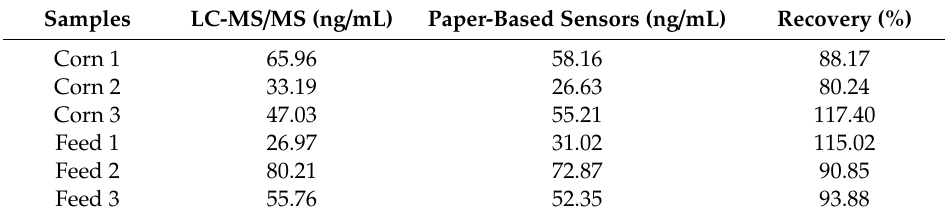
Table 3. Detection of DON in